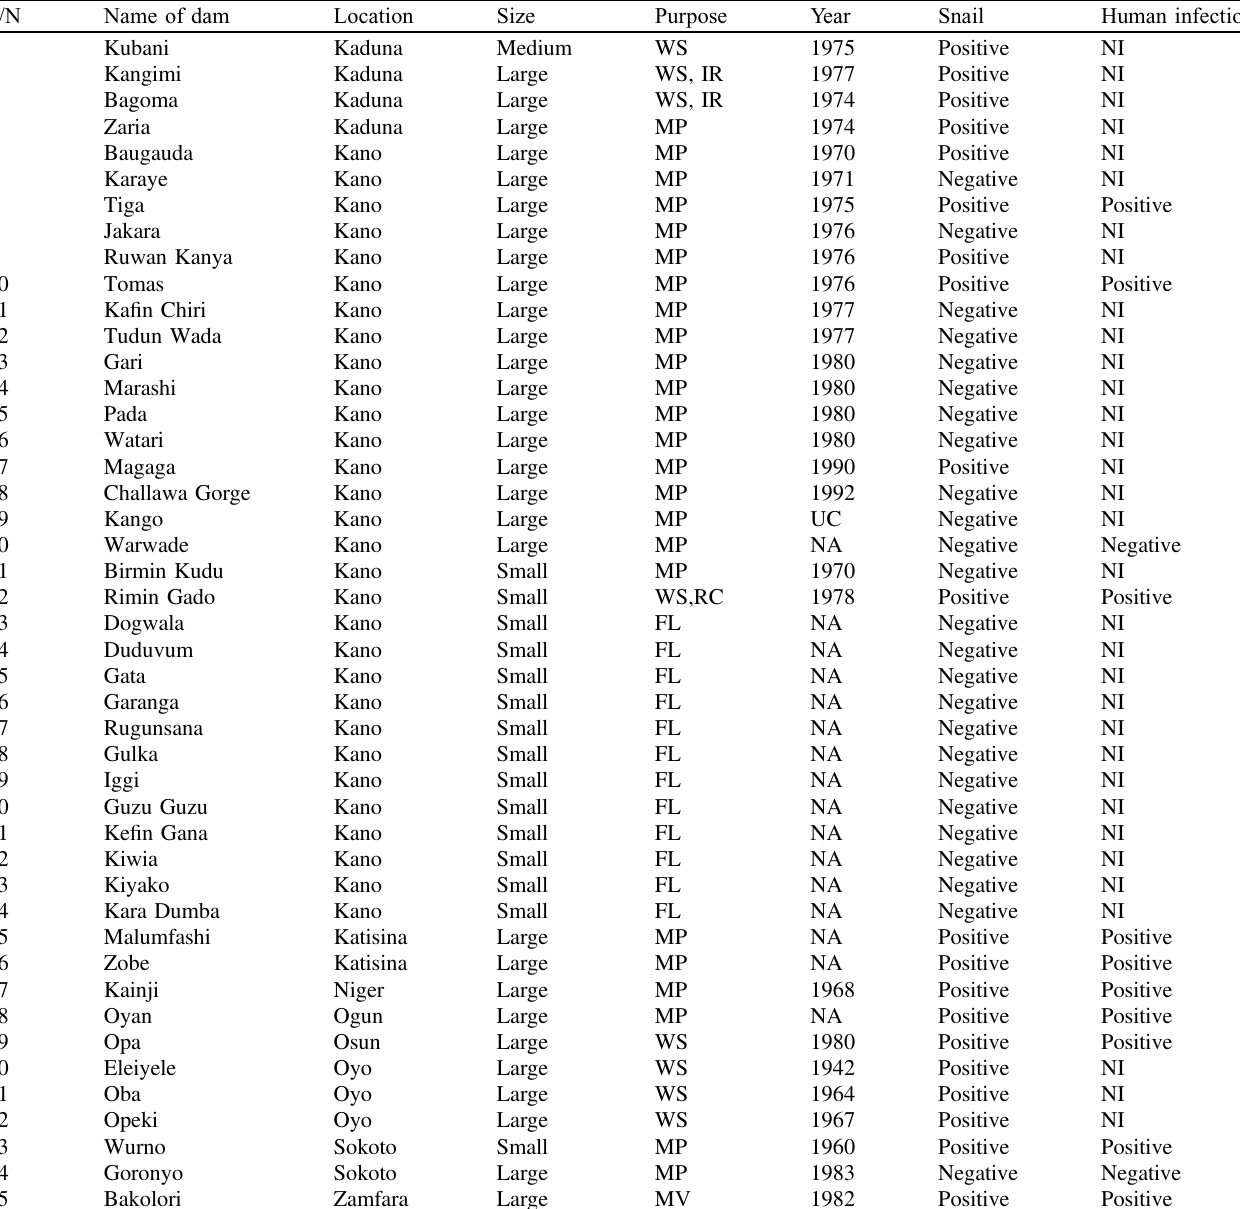
Table 3. The distribution of the snail host and human schistosomiasis in investigated arti fi cial lakes/dams in Nigeria.